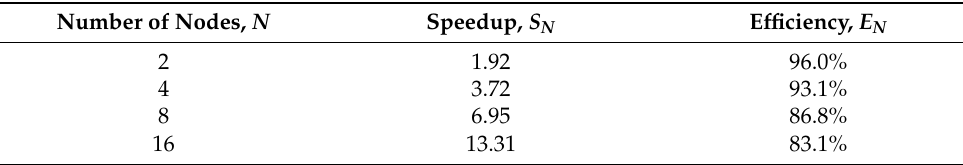
Figure 4. The speedup ( S , red) and the efficiency ( E , green) of the parallelization depending on the number of computing nodes ( N ) for the aPMEC algorithm; the maximum possible speedup is indicated by a blue dashed line. Table 3. Speedup and parallelization efficiency for the aPMEC algorithm. Number of Nodes,